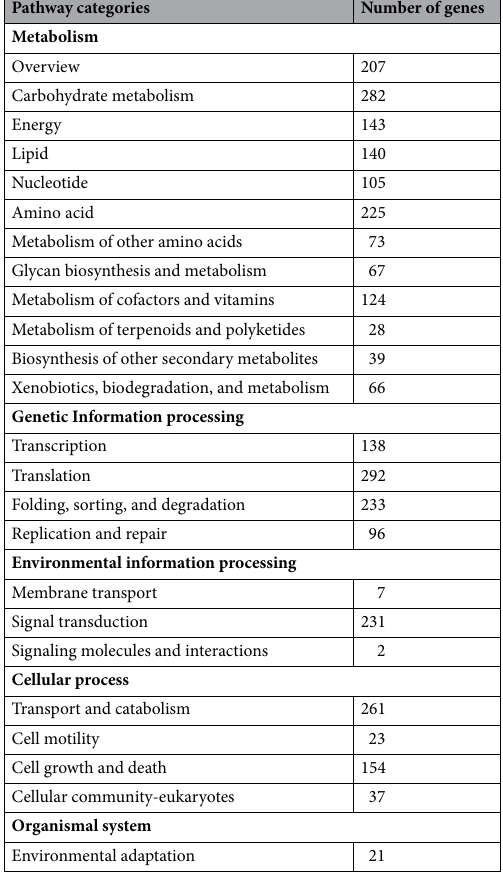
Table 2. KEGG Pathway analysis of the predicted genes of S. sclerotiorum ‘ESR-01’ isolate.